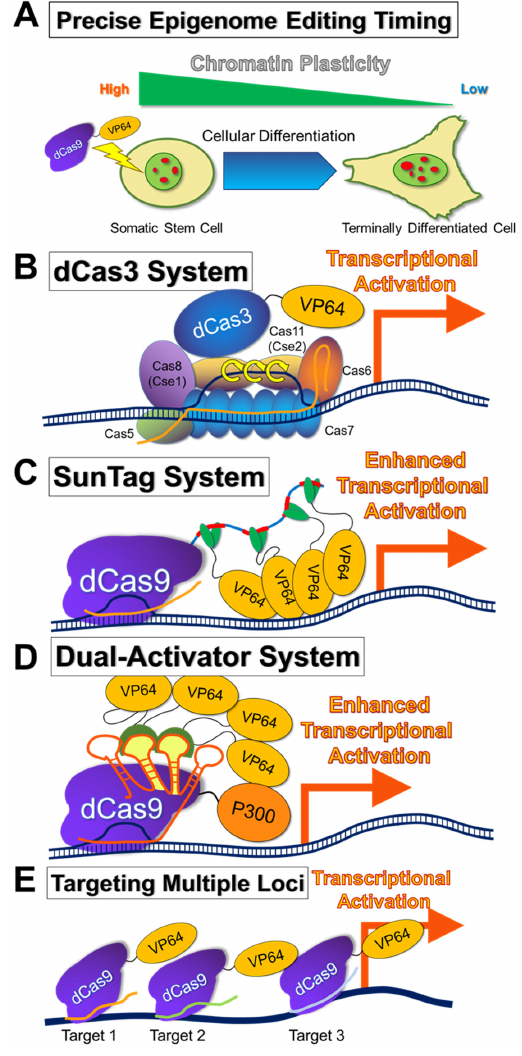
Figure 4. Strategies to improve therapeutic epigenome editing ( A ) Upon differentiation, the cell nuclei (light green) lose chromatin plasticity through forming heterochromatin structures (red dots)